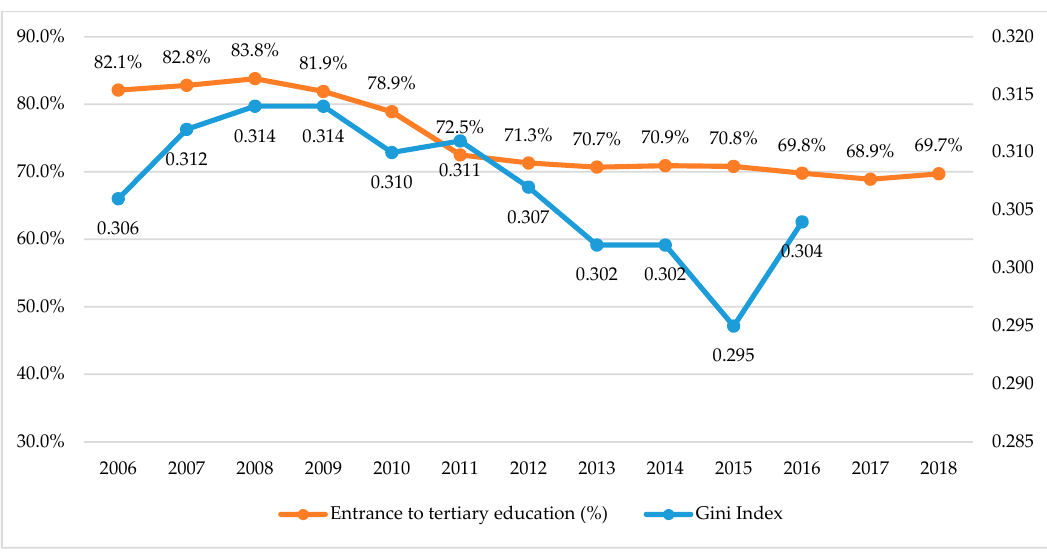
Figure 2. Changes in adolescents’ perceived economic status and school achievement. Changes in the proportion of “middle-low and low” responses to economic status and school achievement. Economic status: Annual proportion of participants who responded “low middle” plus “low” among all participants. School achievement: Annual proportion of participants who responded “low middle” plus “low” among all participants.